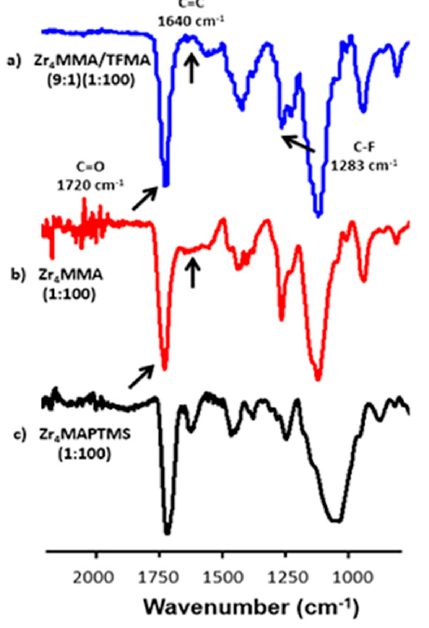
Figure 2. FT-IR spectra of samples: ( a ) Zr 4 MMA/TFMA (9:1) (1:100), ( b ) Zr 4 MMA (1:100) and ( c ) Zr 4 MAPTMS (1:100) in the region between 500 and 2500 cm − 1 . In Figure S1, the peaks around 3000–2900 cm − 1 of the MMA and TFMA-based samples are due to aliphatic C-H stretching [14]. The bands at 1463 cm − 1 and 1426 cm − 1 are related to the bending of CH 3 and the band at 1194 cm − 1 corresponds to the asymmetric stretching of C–O–C [20]. Another meaningful signal is the peak around 1283 cm − 1 , related to the stretching of C-F bond, characteristic of TFMA-based copolymers [28]. The band related to C=C double bonds belonging to the oxocluster (as well as to the monomer) is found at 1640 cm − 1 . The Zr 4 MMA/TFMA samples show a negligible intensity of C=C signal in every sample. The very low C=C/C=O intensity ratio demonstrates a nearly complete radical polymerisation, even better than Zr 4 MMA/MMA, despite the steric hindrance of the oxocluster. Concerning the hybrid with MAPTMS (Figure S1 and Figure 2c), it is possible to observe a very broad band around 3460 cm − 1 , ascribed to the vibration of surface bound water molecules and to the silanol groups (which also give the band at 1640 cm − 1 ) [29], thus highlighting a not completely condensed silica network [30,31]. The relatively weak absorption bands around 2945 cm − 1 and 2840 cm − 1 are attributed to the stretching of C–H bonds in alkyl and methoxy groups, respectively. The bands at 1717 cm − 1 and 1638 cm − 1 were assigned to the stretching of C=O and C=C groups, respectively; the one related to C=C shows a higher intensity with respect to the other polymers, revealing a less efficient radical polymerisation for this material. The broad band centred at 1080 cm − 1 and the weaker band at 780 cm − 1 confirm the presence of a Si–O–Si network, with its asymmetric and symmetric stretching, respectively [32]. Subsequently, in order to investigate the presence of the oxocluster in the synthesised hybrids, Raman measurements were carried out, since the stretching vibrations of Zr–O–Zr appear at low wavenumbers (<250 cm − 1 ) and cannot be detected using conventional FTIR [15,33,34]. In Figure 3, the superimposition of the Raman spectra of the oxocluster and of the hybrid materials is